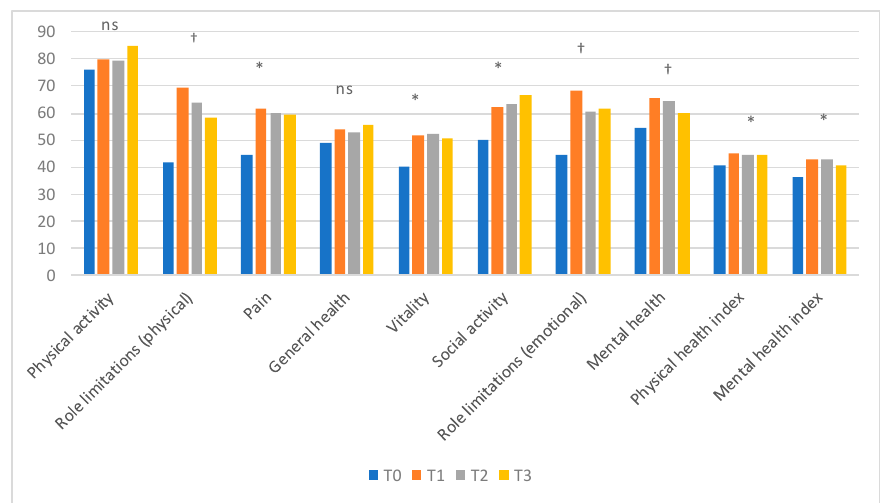
Figure 4. SF-36 results. * T0 vs other: p < 0.05; † T0 vs T1: p < 0.05; ns: not significant. The reported results refer to the 41 patients evaluated at T3.